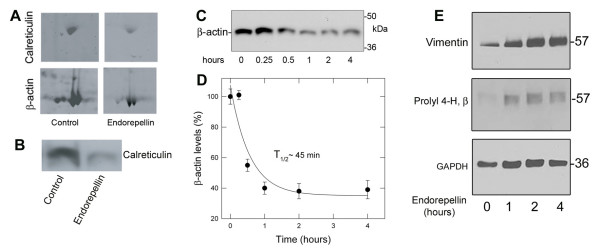
Immunoblotting supports the proteomic analysis and indicates relative changes of various endothelial cell proteins evoked by endorepellin treatment. (A) Close up view of two representative 2-D gels, depicting the decline in calreticulin and β-actin levels. Notice that the major actin isoforms also show reduced staining intensity in response to endorepellin treatment. (B) Immunoblotting of control and endorepellin-treated endothelial cell lysates using an antibody against human calreticulin. Equal amounts of total proteins were loaded. (C) Immunoblot analysis of β-actin levels following treatment with ~200 nM endorepellin for the designated time intervals. (D) The kinetic data for β-actin expression levels were derived from immunoblotting data as presented in C. Essentially HUVEC β-actin expression levels were examined by Western blot following exposure to endorepellin for the indicated time points. β-actin levels were quantified over similar amounts of protein loading and graphed as percent β-actin levels (based upon time point 0) versus exposure to endorepellin treatment (hours). The data were graphed in SigmaPlot v9 and fit by non-linear regression analysis. Each data point represents the mean ± S.E.M. from three experiments. The T1/2 of ~45 min. represents the time to reduce β-actin levels by 50% as compared to the control. (E) Immunoblot analysis of vimentin and prolyl 4-hydroxylase, β subunit protein levels following endorepellin treatment for the indicated time points. GAPDH is shown as loading control. All verification experiments presented in panels C-E utilized new samples of endorepellin-treated HUVEC lysates, separate from those used in proteomic analysis.